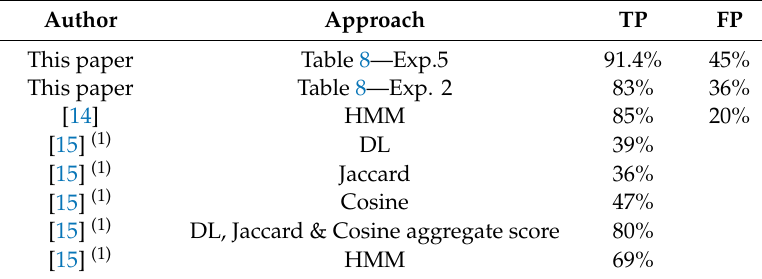
Table 9. Comparison with other approaches.